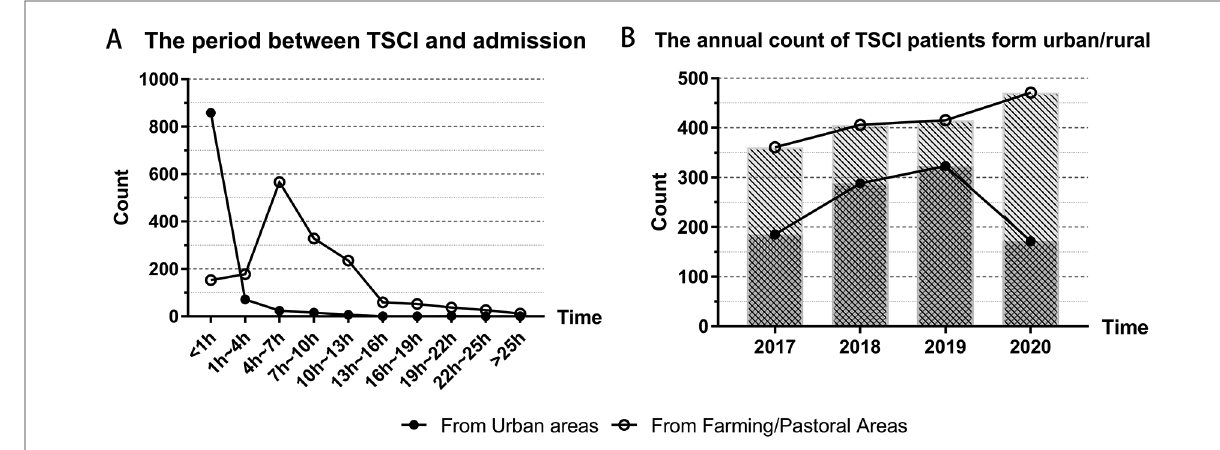
FIGURE 5 Urban and rural differences in patient treatment: ( A ) The patient ’ s waiting time from injury to admission; ( B ) The annual count of TSCI patients form urban and